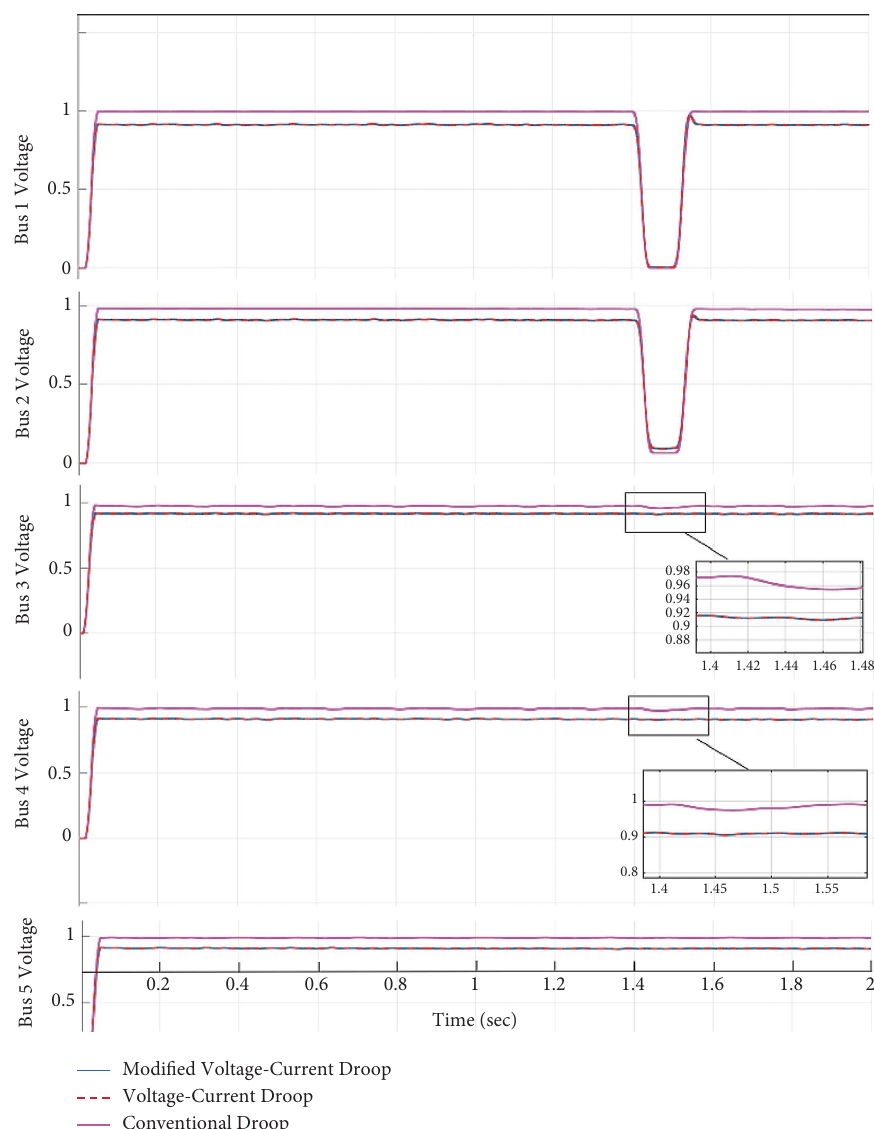
Figure 21: Voltage of microgrid in p.u during fault condition.